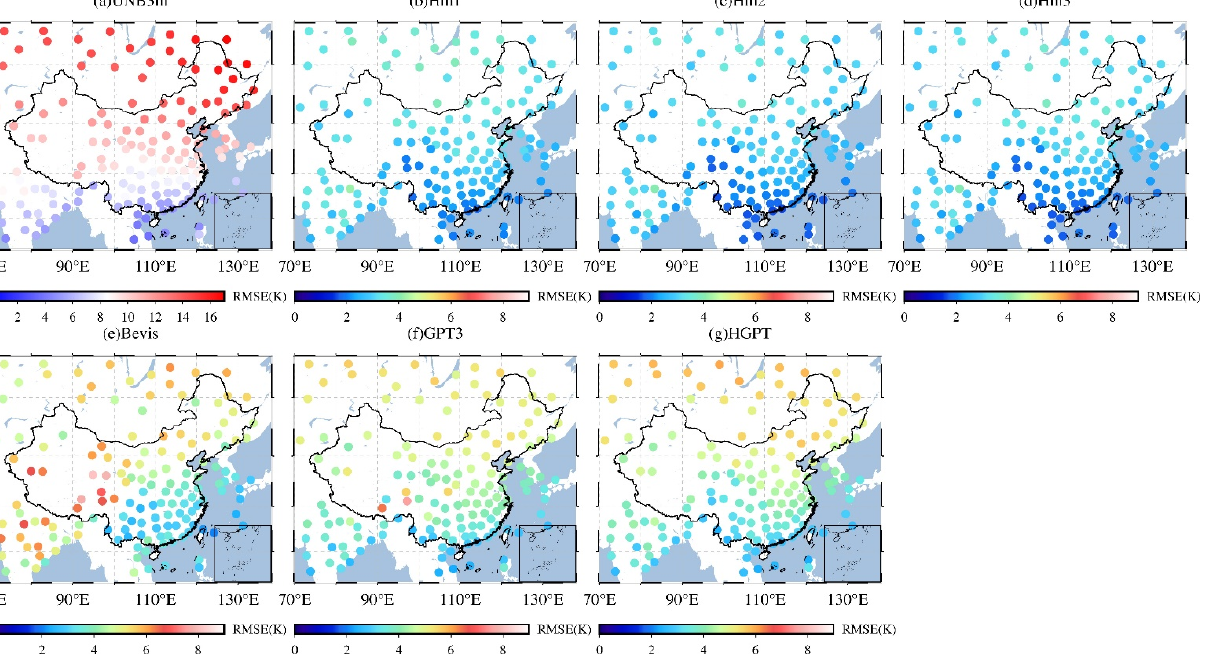
Figure 9. Statistics of RMSEs at each radiosonde station of each model. Figure 9 shows that the RMSEs of the three hybrid models are much smaller than the UNB3m model. Simultaneously, compared with the RMSEs of the Bevis model, the GPT3 model, and the HGPT model, the hybrid models also have a significant improvement. The number of sites with an RMSE value smaller than 3.0 K is 0 for the UNB3m model, 74 for the hybrid model 1, 101 for the hybrid model 2, 89 for the hybrid model 3, 22 for the Bevis model, 20 for the GPT3 model, and 21 for the HGPT model. The above results show that